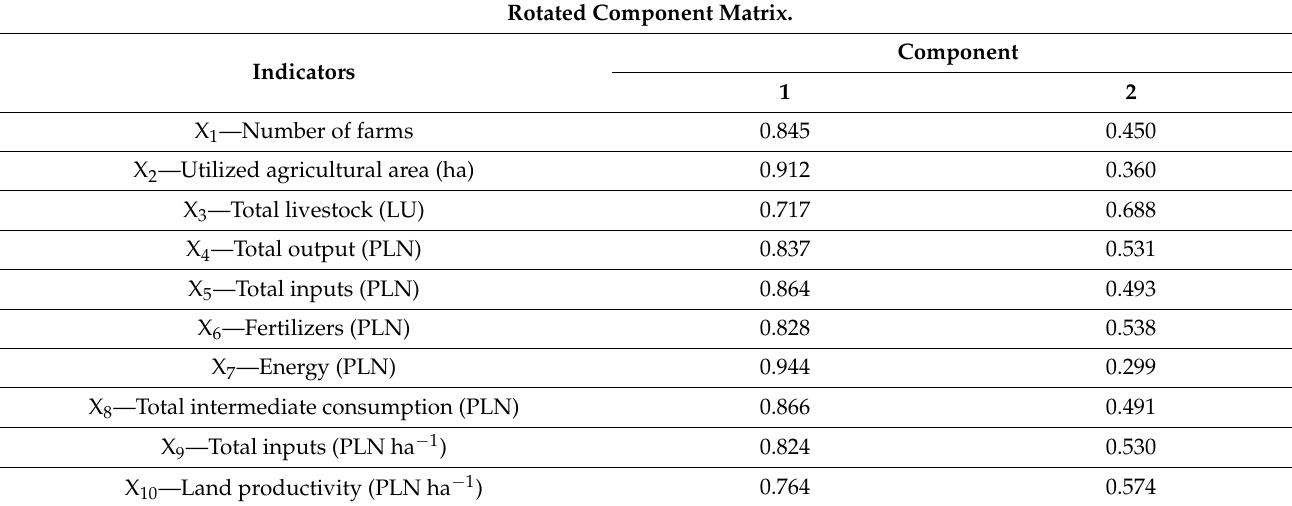
Table A3. Eigenvalues and proportions of total variance in 15 years as explained by the first two principal components for original traits and correlation coefficients between these traits and the first three PCs on milk production farms. Rotated Component